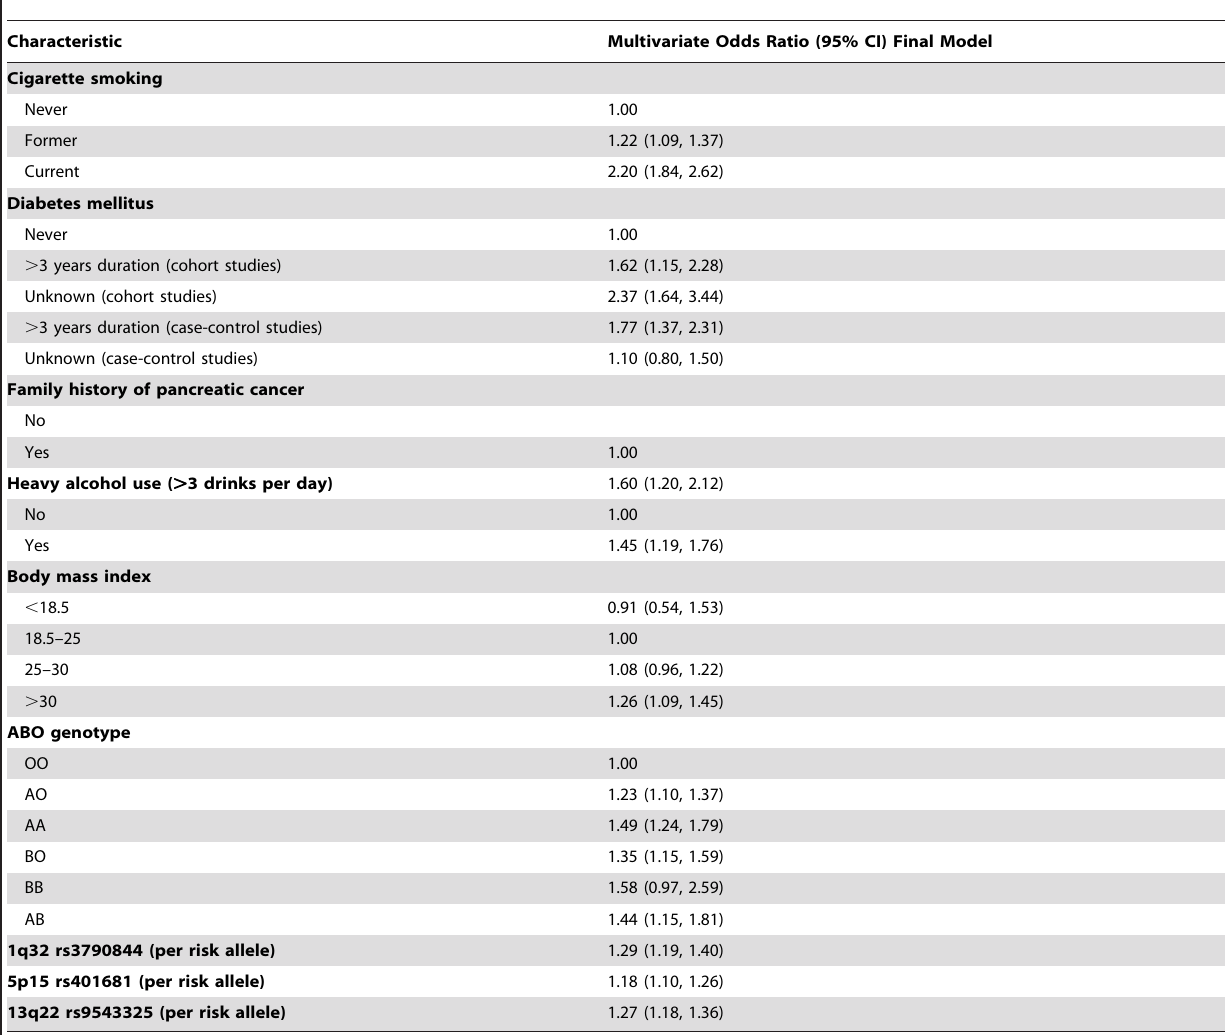
Table 2. Association between pancreatic cancer risk and smoking, personal history of diabetes, family history of pancreatic cancer, alcohol use, body mass index, and known genetic